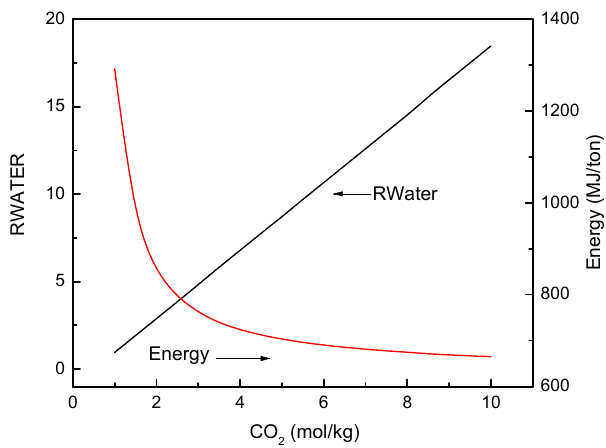
Figure 5. The effect of draw solution concentration on the FO process performance using NH 3 -CO 2 as the draw solute.